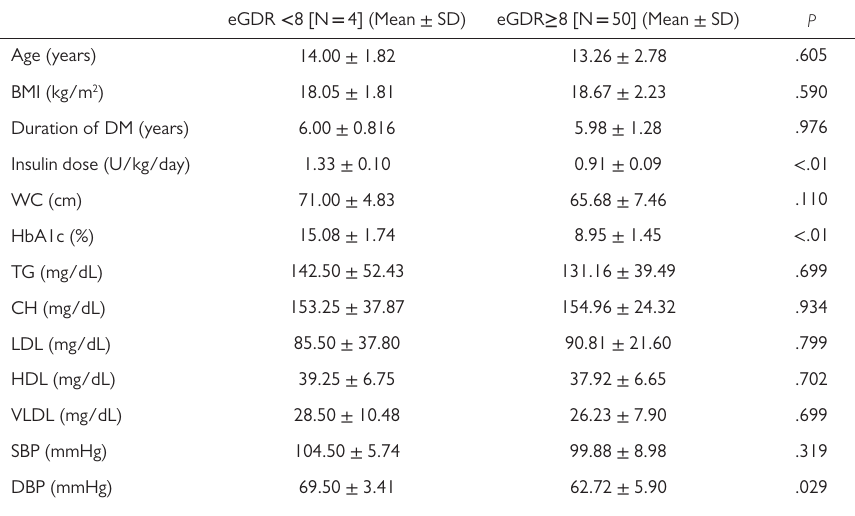
Table 3. Comparison of Various Characteristics of Patients with eGDR < 8 and eGDR ≥ 8 in Children and Adolescents